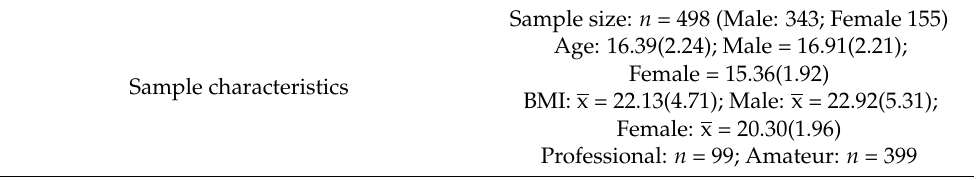
Table 2. Sample characteristics and epidemiological aspects.